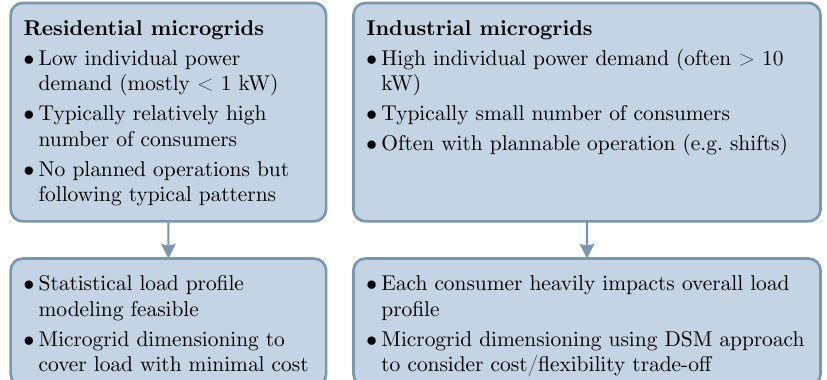
Figure 1. Comparison of residential and industrial consumer characteristics in